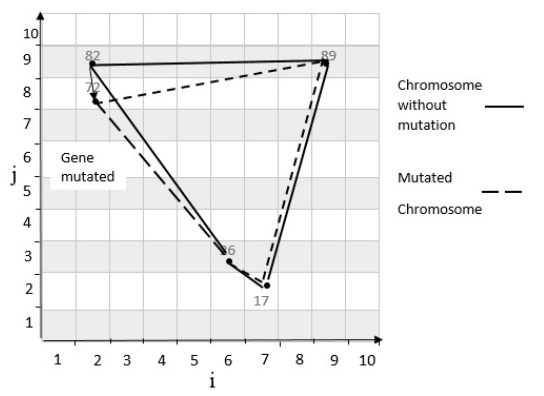
Figure 14. Mutated